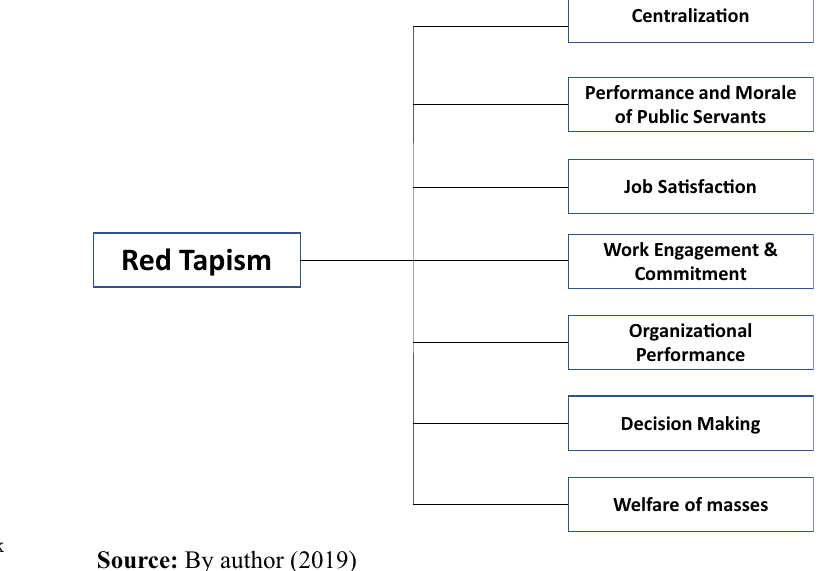
Figure 1. Conceptual